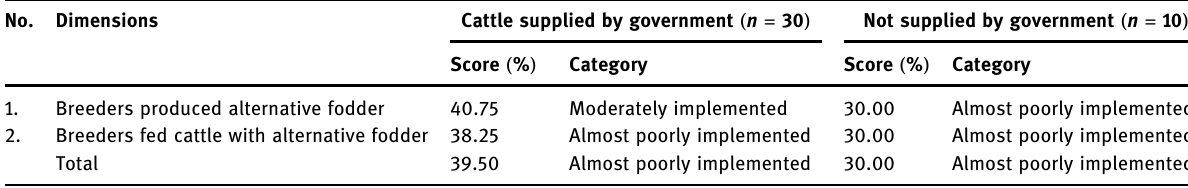
Table 2: Breeders ’ behavior in producing alternative fodders No.